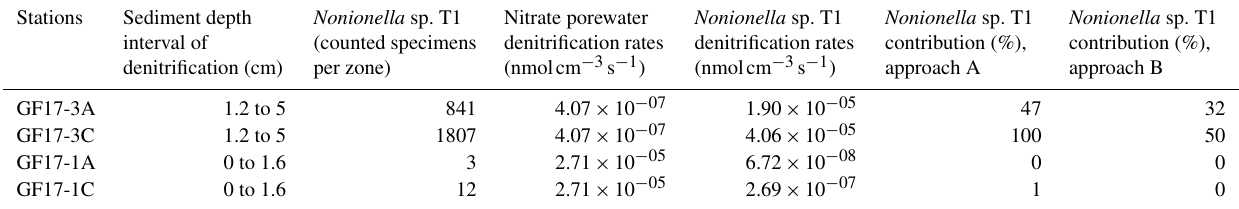
Table 2. Summary of the NIS Nonionella sp. T1 contributions to benthic denitrification in the Gullmar Fjord. The porewater denitrification zones come from PROFILE modeling (Fig. 5d and h). To estimate the contributions of Nonionella sp. T1, the number of counted specimens per zone was used. Two different approaches were used to estimate the contribution of Nonionella sp. T1: (A) Nonionella sp. T1 denitrification rate divided by nitrate porewater denitrification rate and (B) Nonionella sp. T1 denitrification rate divided by nitrate porewater denitrification rate plus Nonionella sp. T1 denitrification rate. The calculations are detailed in Eq. (S2) in the